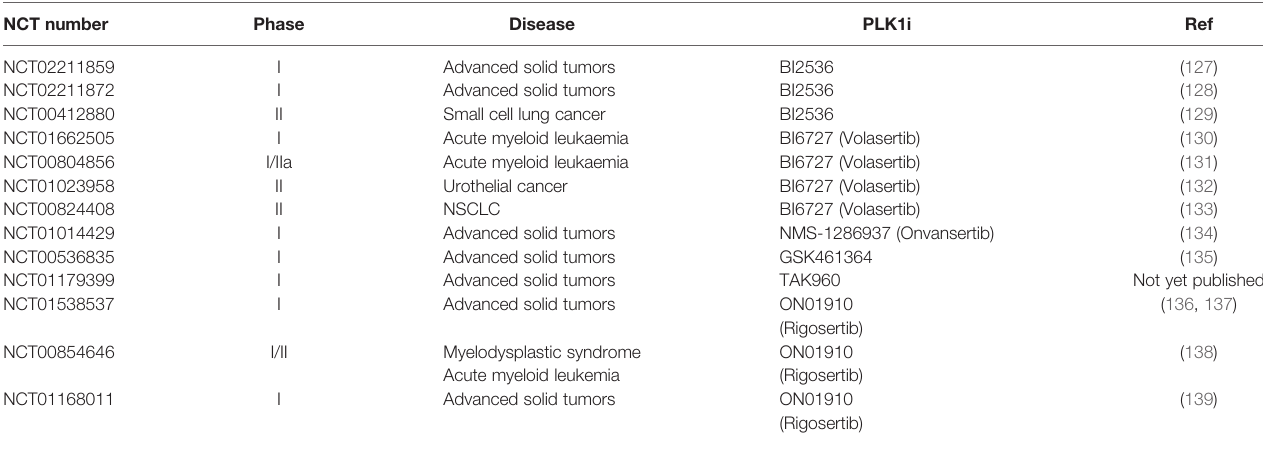
TABLE 1 | Clinical trials based on PLK1